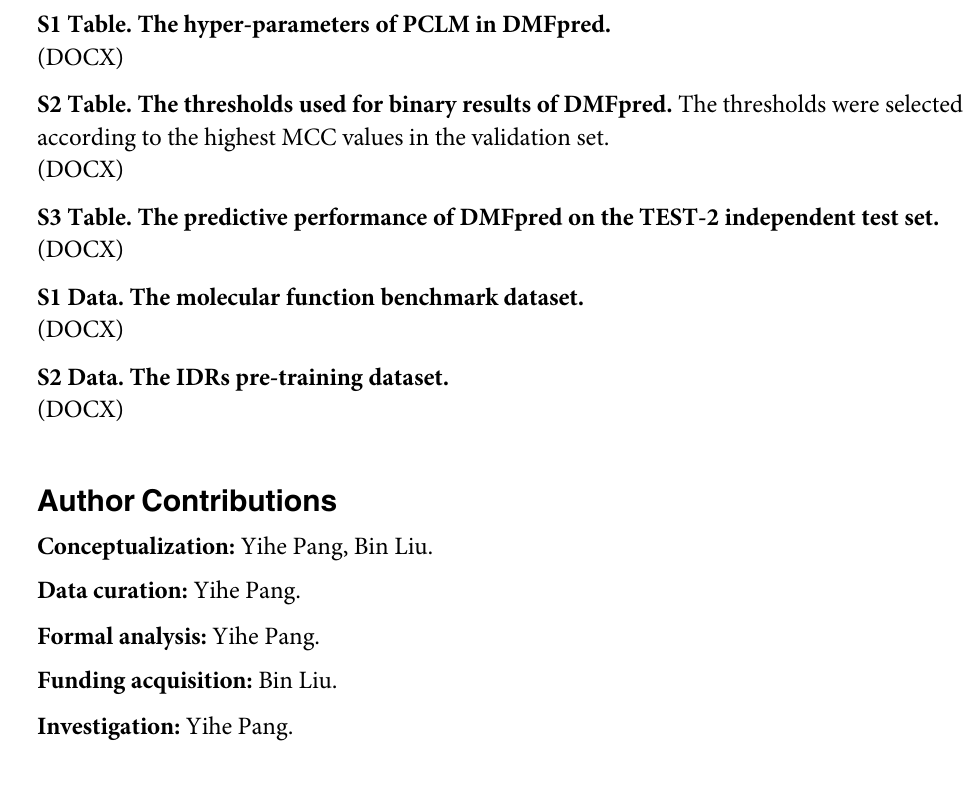
S1 Fig. The five disordered molecular functions and their sub-level annotations collected from the DisProt database. S2 Fig. The ROC curves of DMFpred for predicting five disordered molecular functions. S1 Table. The hyper-parameters of PCLM in DMFpred. S2 Table. The thresholds used for binary results of DMFpred. The thresholds were selected according to the highest MCC values in the validation set. S3 Table. The predictive performance of DMFpred on the TEST-2 independent test set. S1 Data. The molecular function benchmark